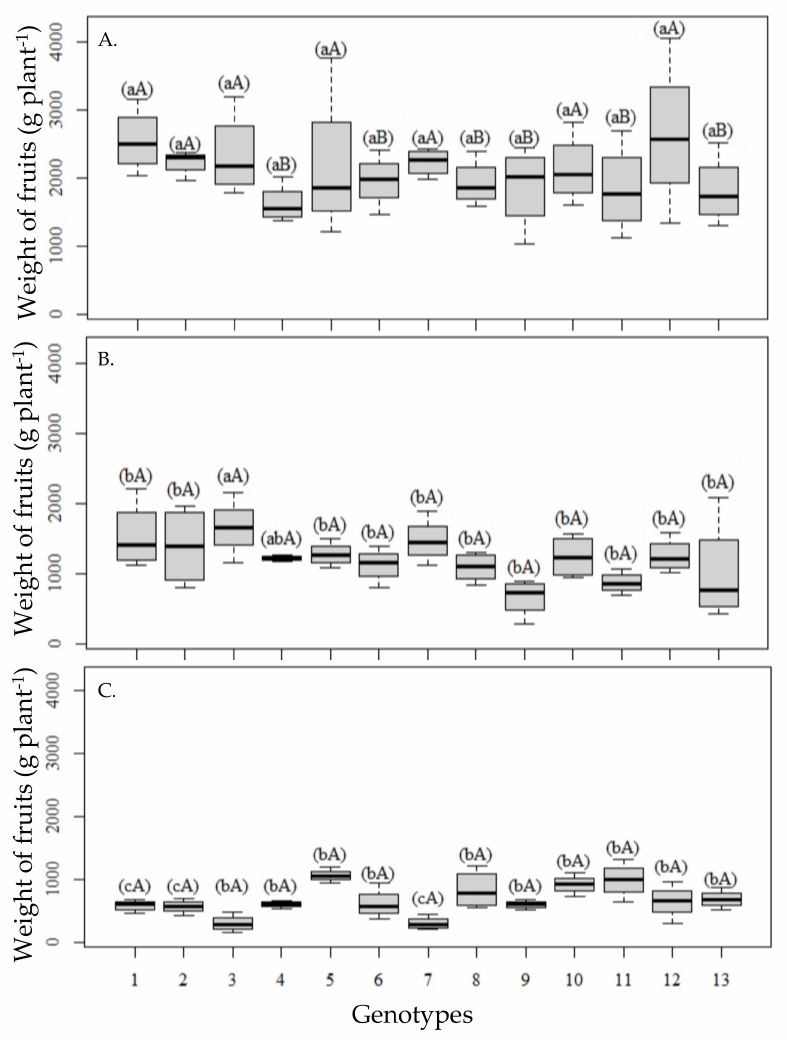
Figure 2. Boxplot relative to the average weight of fruits per plant of 13 citrus rootstocks in combina- tion with ‘Tahiti’ acid lime ( Citrus × latifolia (Yu. Tanaka) Tanaka) under irrigation with waters of 0.14 ( A ), 2.40 ( B ) and 4.80 dS m − 1 ( C ), in the first year. For identification of genotypes, see Table 1. Boxplots with the same lowercase letter do not differ statistically, according to the Tukey test between salinity levels ( p ≤ 0.05), and those with the same uppercase letter belong to the same genotype group, according to the Scott–Knott test ( p ≤